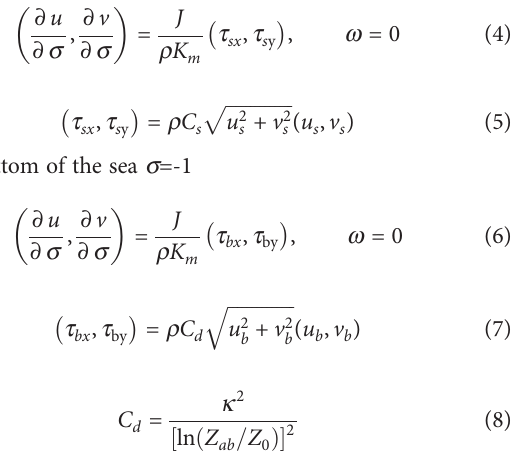
Figure 1F . Among them, the wave model provides parameters such as signi fi cant wave height, wave direction, wavelength, spectral peak period, bottom orbital speed, bottom orbital period and other parameters to the ocean model. The ocean model provides the depth-weighted average Doppler fl ow rate and water level to the wave model. The bottom boundary layer model obtains the fl ow velocity from the hydrodynamic model, the wave elements from the wave model, and the bottom bed roughness and other variables from the bottom boundary layer model. After calculation, the bottom stress is fed back to the ocean model. Current-wave coupling is approached through radiation stress, bottom boundary layer, surface stress, and morphology. The radiation stresses are added into the momentum equations of FVCOM to include the wave-driven motions (FVCOM user